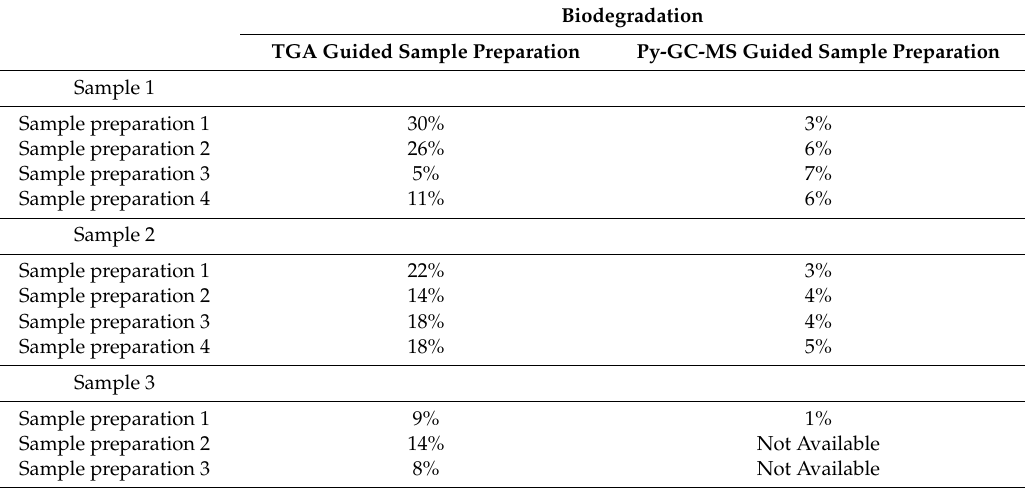
Table 3. Comparison of biodegradation results of independent replicates for samples 1–3 with and without the application of the described purification protocol and validation of sample purity using Py-GC-MS quantification of residual